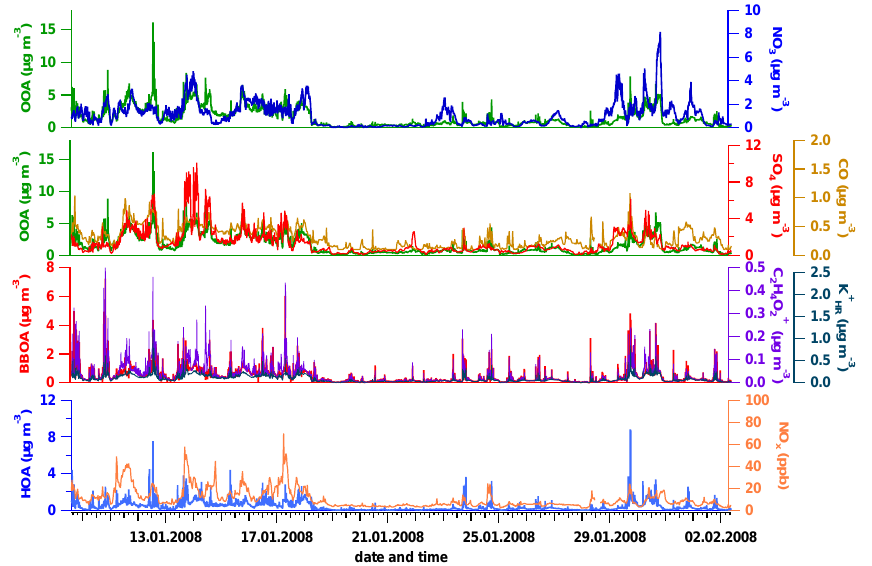
Fig. 3. Time series of the 3 factors and their selected tracer species (AMS time resolution 5 min, gas tracers time resolution 30 min).